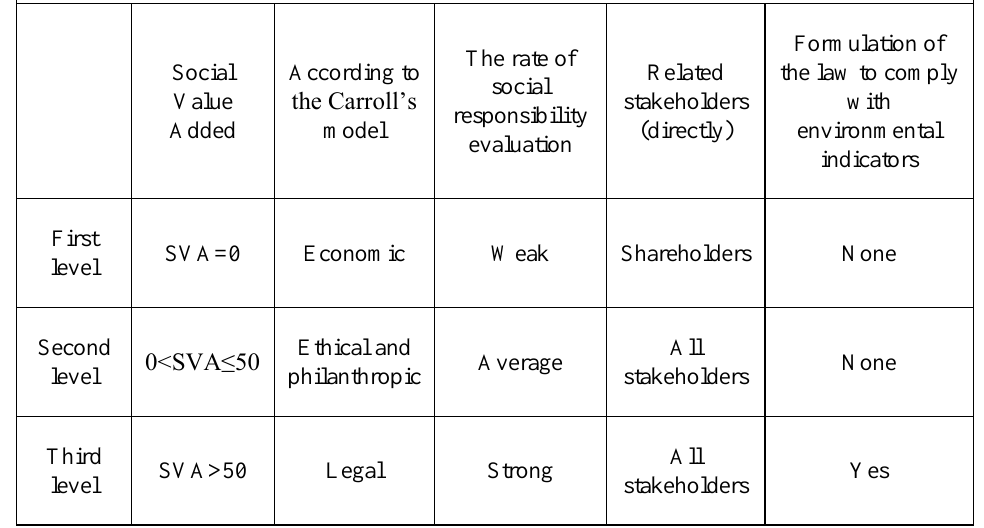
Table (1): Model of Evaluating Corporate Social Responsibility Using Social Value